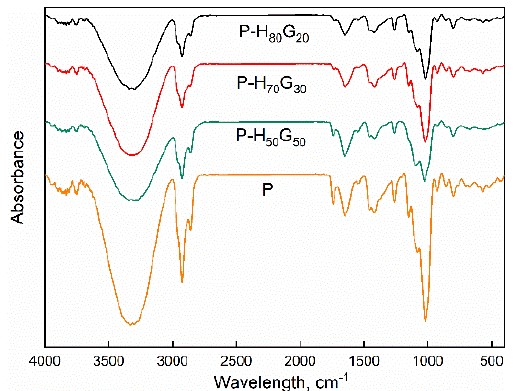
Figure 4. ATR spectra of pectin and pectin nanocomposites.